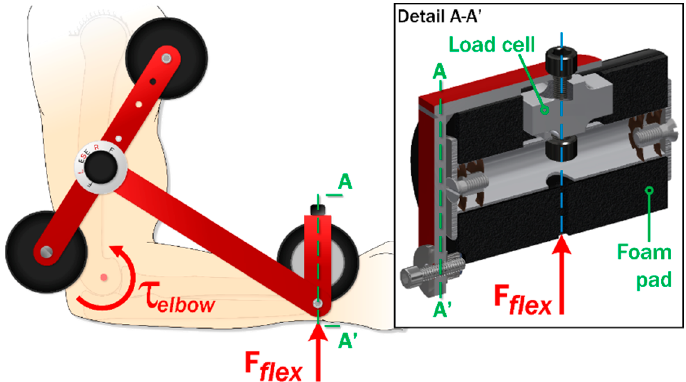
Figure 2. LSMD mode of operation—a wrist pad (Detail A-A’) with an integrated load cell is aligned with the wrist of the wearer, allowing the load cell to measure the flexion force ( F flex ) corresponding to the elbow torque ( τ elbow ) generated by the wearer. The identical principles apply in extension configuration.